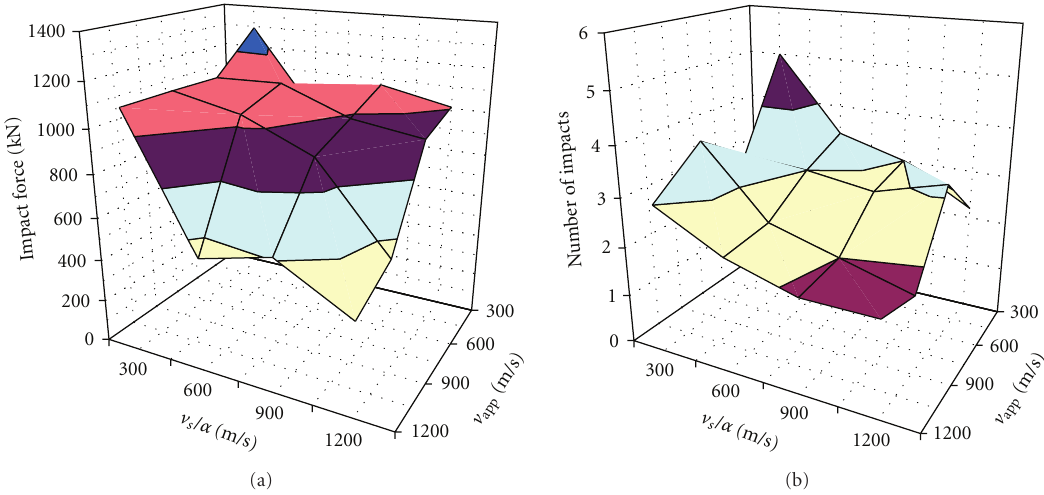
Figure 14: (a) Pounding forces varying with correlation level of input ground motions; (b) Total number of registered impacts (mean value). Registered impacts follow a similar tendency